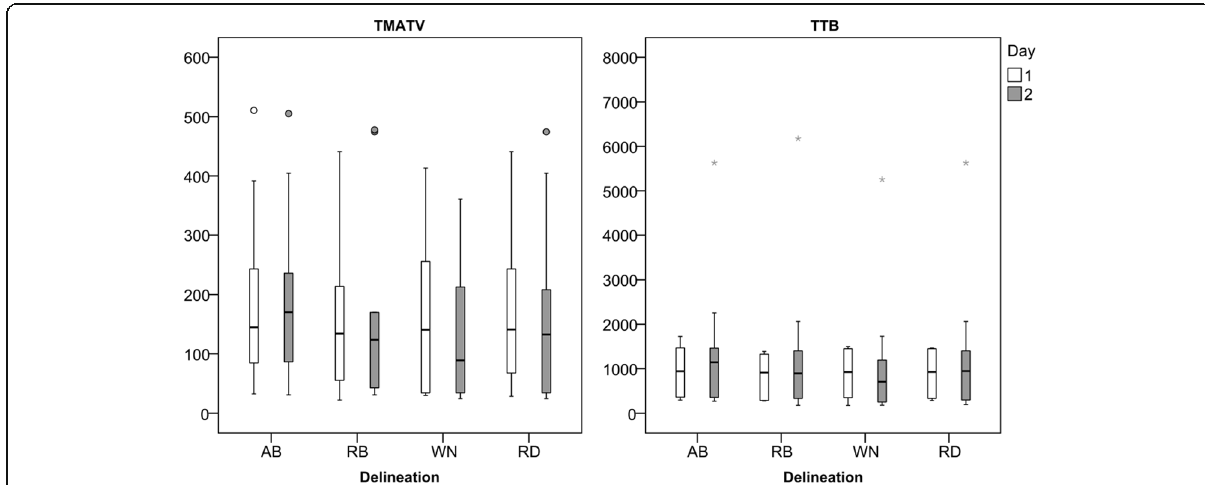
Fig. 1 Box plots with median and range of TMATV (left panel) and TTB (right panel). Both panels show data from the delineations in images acquired at the first and second day of scans, indicated by the colours. Images were acquired 60 min post-injection and reconstructed following EARL compliant settings. TMATV in milliliter and TTB in